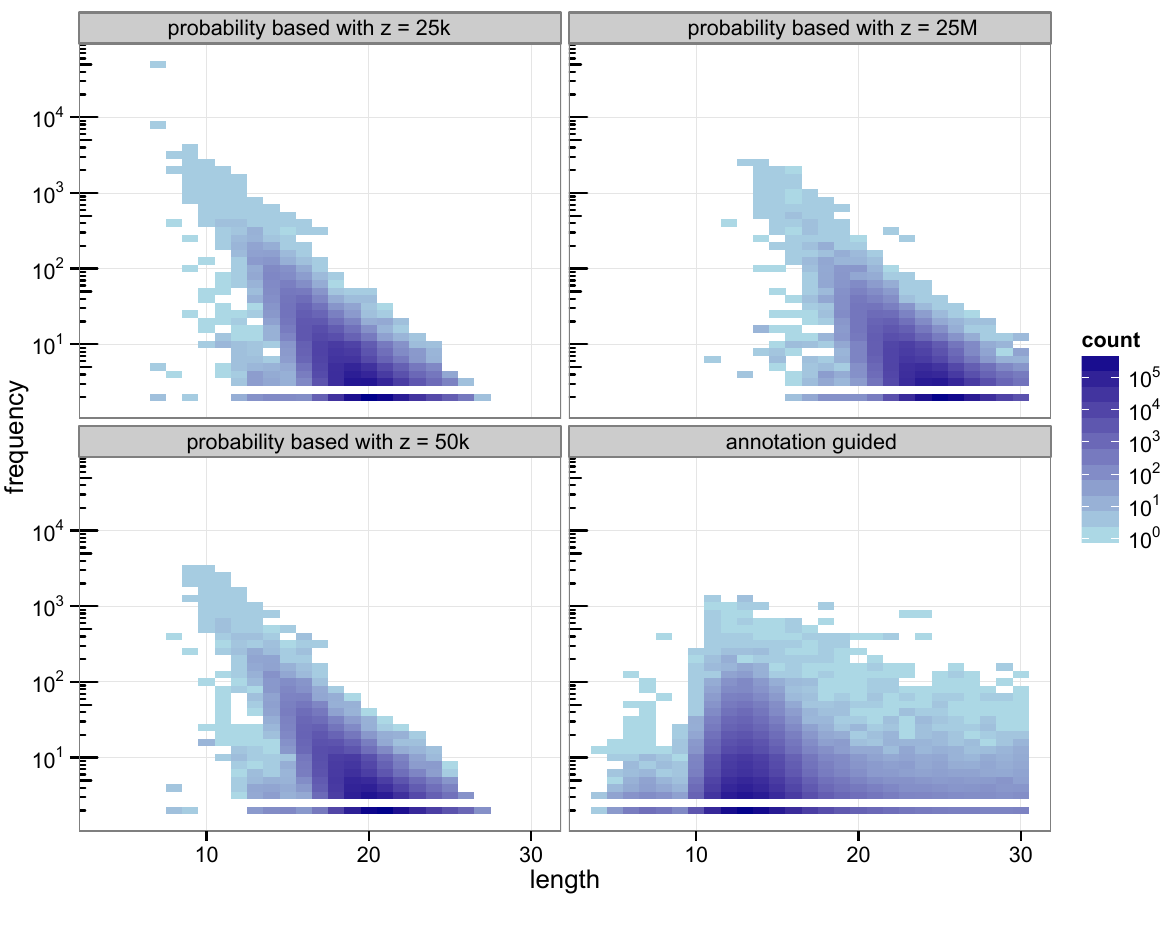
Figure 2. Heat map of the number of markers with a specific length and their number of